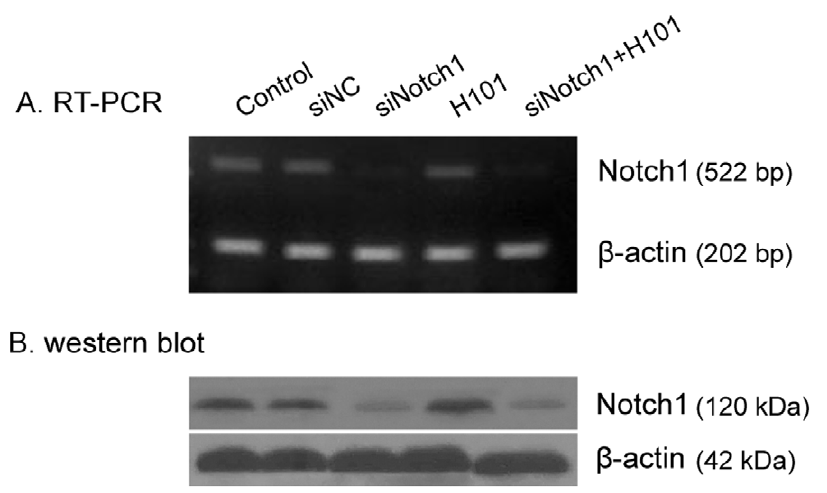
Figure 1. Notch1 gene knockdown by siRNA. A. Semi-quantitative RT-PCR analysis of Notch1gene transcripts in HeLa-S3 cells. The experiment was performed 48 hours after siNotch1 (100 nmol/l) transfection with or without H101 infection (multiplicity of infection (MOI) =100). b -actin was used as the internal control for normalization. B. Western Blot analysis of Notch1 protein in HeLa-S3 cells. The experiment was performed 72 hours after siNotch1 (100 nmol/l) transfection with or without H101 infection (multiplicity of infection (MOI) =100). Western bands were scanned and normalized over the internal control b -actin.